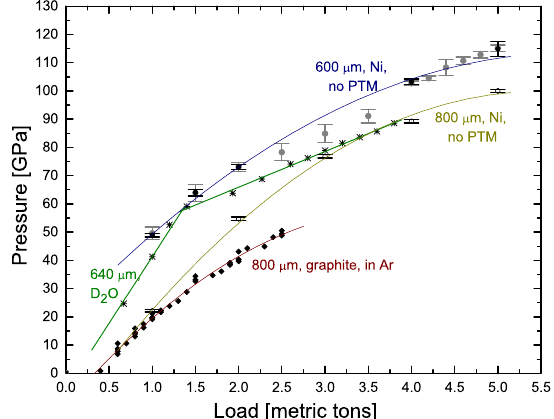
Figure 2. Pressure-load curves obtained from nickel, water ice and graphite. The pressure for the Ni and D 2 O data were obtained from the diffraction data themselves using Ni and D 2 O equations of state 30,31 , respectively. For those, pressures were determined through Gaussian fits to the diffraction data (black circles and stars, respectively). Additionally, for short runs, pressures were determined visually from the peak positions (grey circles) in one case. For the graphite loaded in Ar pressure was obtained using the ruby fluorescence method (black diamonds). Refer to the main text and the methods section for further details. In all cases, a fit was